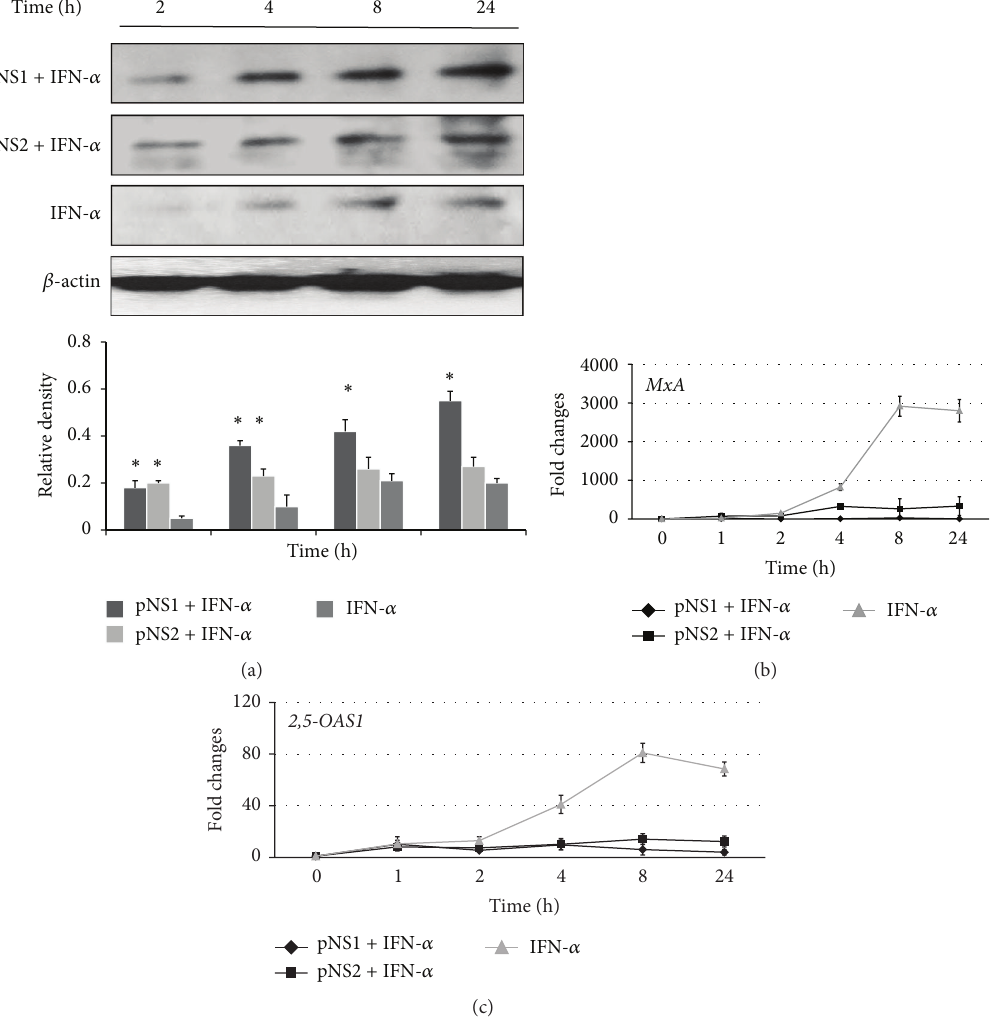
Figure 4: RSV NS proteins decreased the induction of IFN- 𝛼 -induced antiviral genes through SOCS1 expression. A549 cells were treated with 5000 U/mL IFN- 𝛼 for 30 min and were then transfected with pNS1 or pNS2 for the indicated times. Cellular total protein lysates were subjected to Western blot analysis of SOCS1 (a). The data were normalized to the level of 𝛽 -actin and shown as the relative density from three independent experiments. 𝑝 < 0.05 versus IFN- 𝛼 . Total RNA was subjected to qPCR. The cDNA levels were analyzed using qPCR to assess the mRNA amounts of MxA or 2,5-OAS1 (b, c). Equivalent mRNA amounts were normalized to GAPDH mRNA levels and calculated as 𝑛 -fold changes compared with the levels of untreated cells at the respective time points. The results shown are representative of three independent